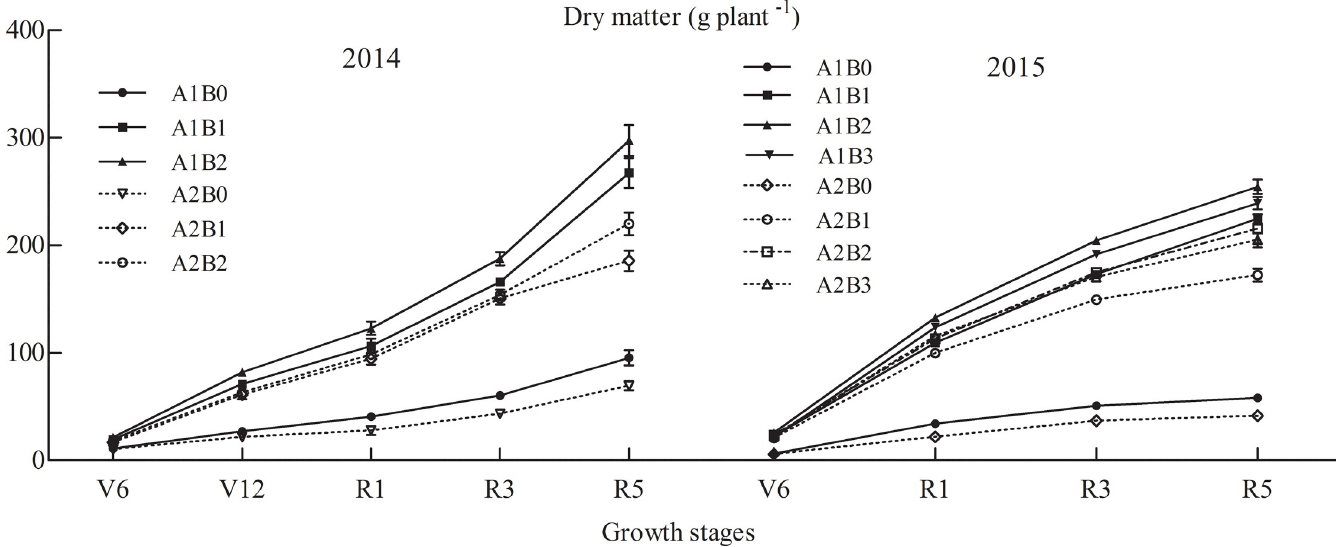
Fig 1. Dry weight per plant in different growth periods of maize under various treatments. Note: V6, jointing (V6); V12, big trumpet; R1, silking (R1); R3, milk-ripe; and R5, maturity. A stands for cultivars: A1, ZH311; A2, XY508. B stands for N treatments: B0, 0 kg � ha -1 ; B1, 150 kg � ha -1 ; B2, 300 kg � ha -1 ; and B3, 450 kg � ha -1 .The point in R5 indicates soluble sugar content in